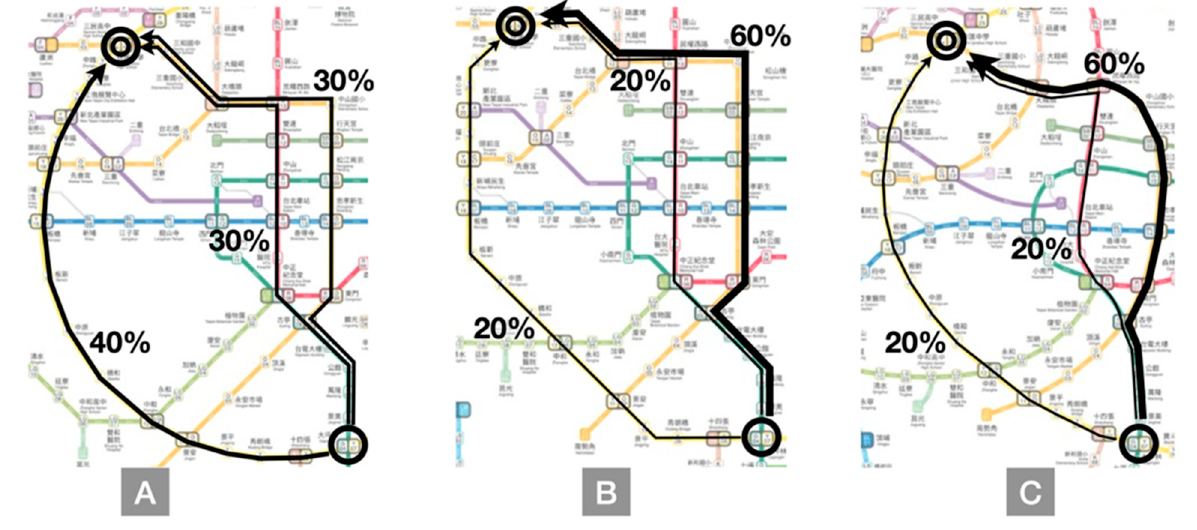
Figure 12. Proposal ( A – C ) showed avoiding a detour was regarded by most participants as more important than several transfers in shorter distance.